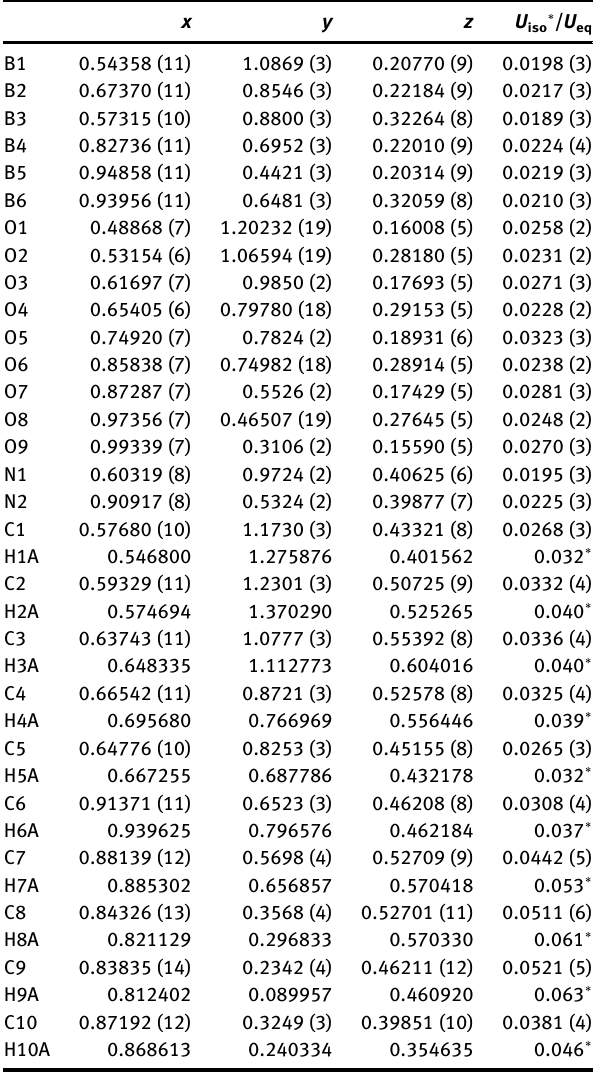
Table  : Fractional atomic coordinates and isotropic or equivalent isotropic displacement parameters (Å 